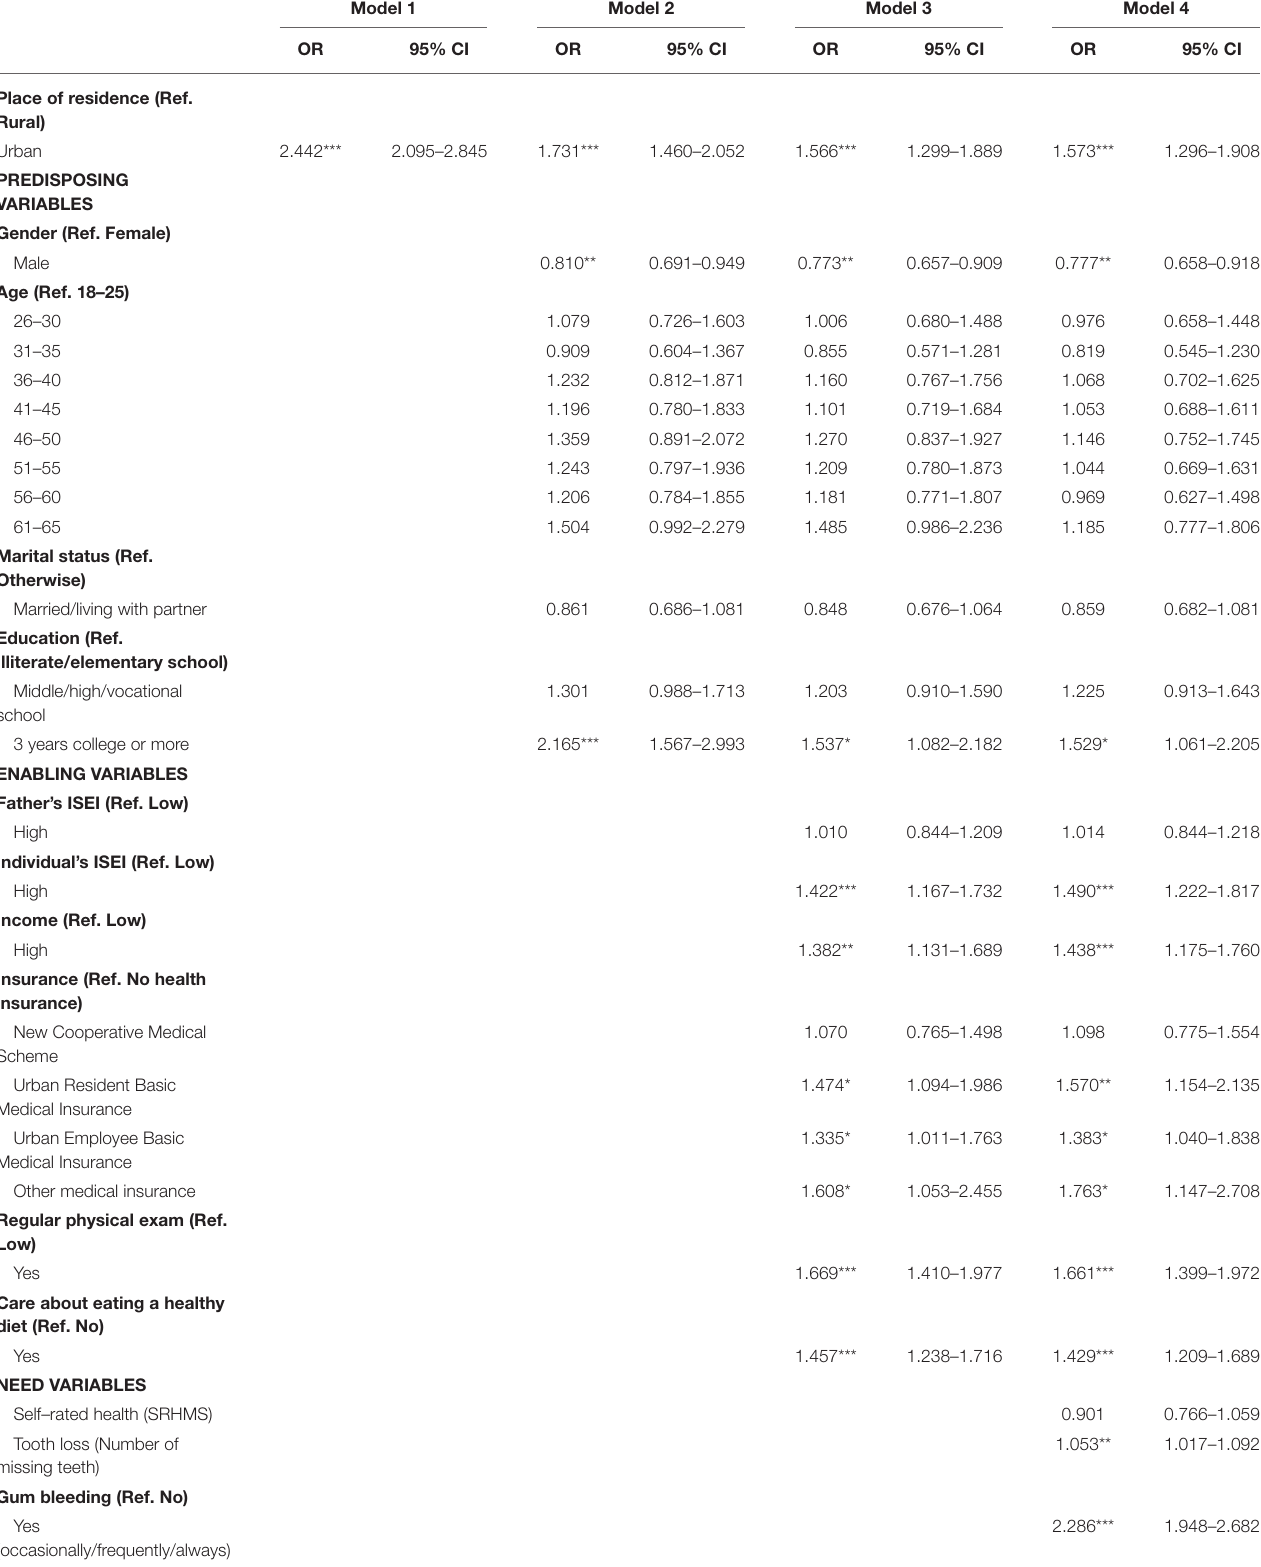
TABLE 2 | Multivariate logistic regression models of having dental services utilization at least once ( N = 4,049,